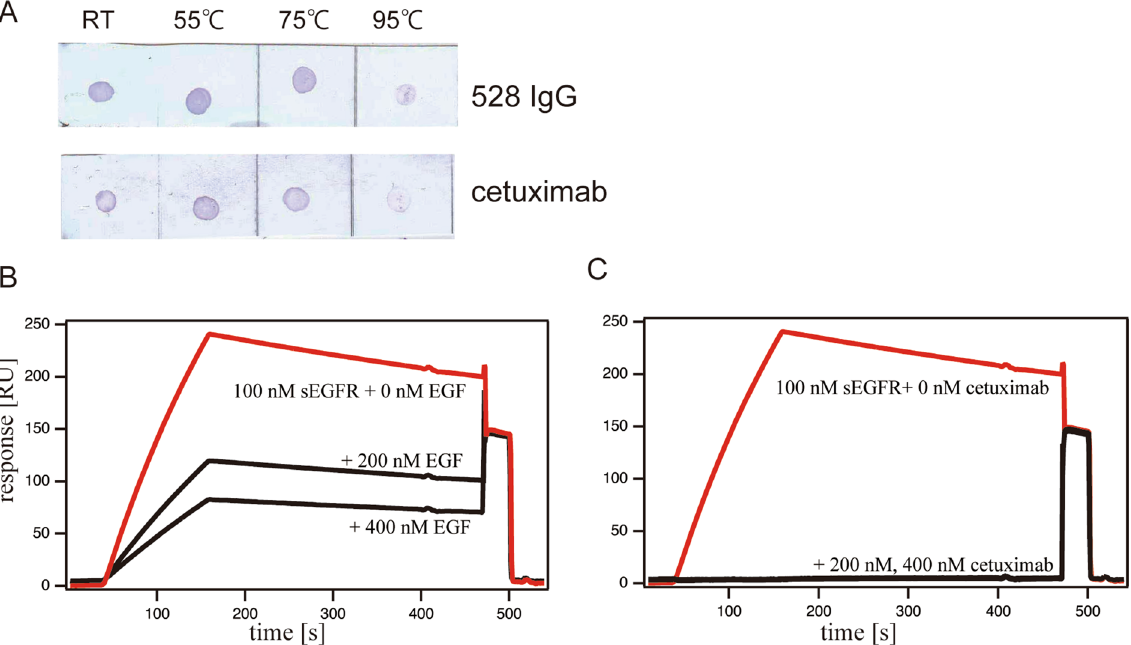
Figure 1. ( A ) Dot blot of heat-treated sEGFR detected by antibodies 528 and cetuximab. Each blotting image was a consecutive membrane strip without cropping. ( B , C ) Competitive Biacore assay between 528 and EGF ( B ) and between 528 and cetuximab ( C ) for binding sEGFR. sEGFR (100 nM) was loaded onto the antibody- immobilized sensor chips with or without its